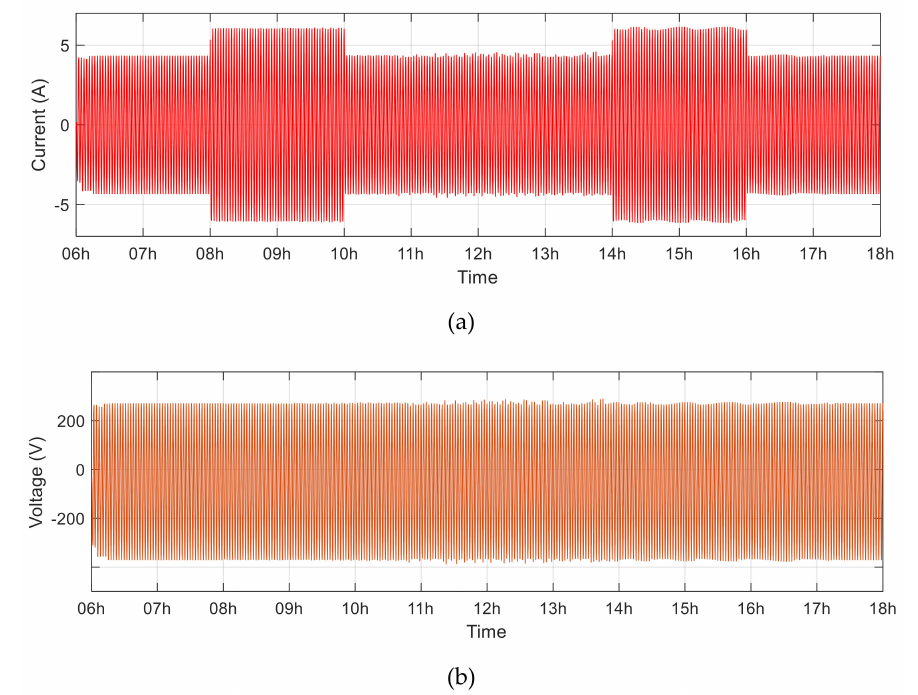
Figure 18. ( a ) Load current variation, ( b ) load voltage variation.